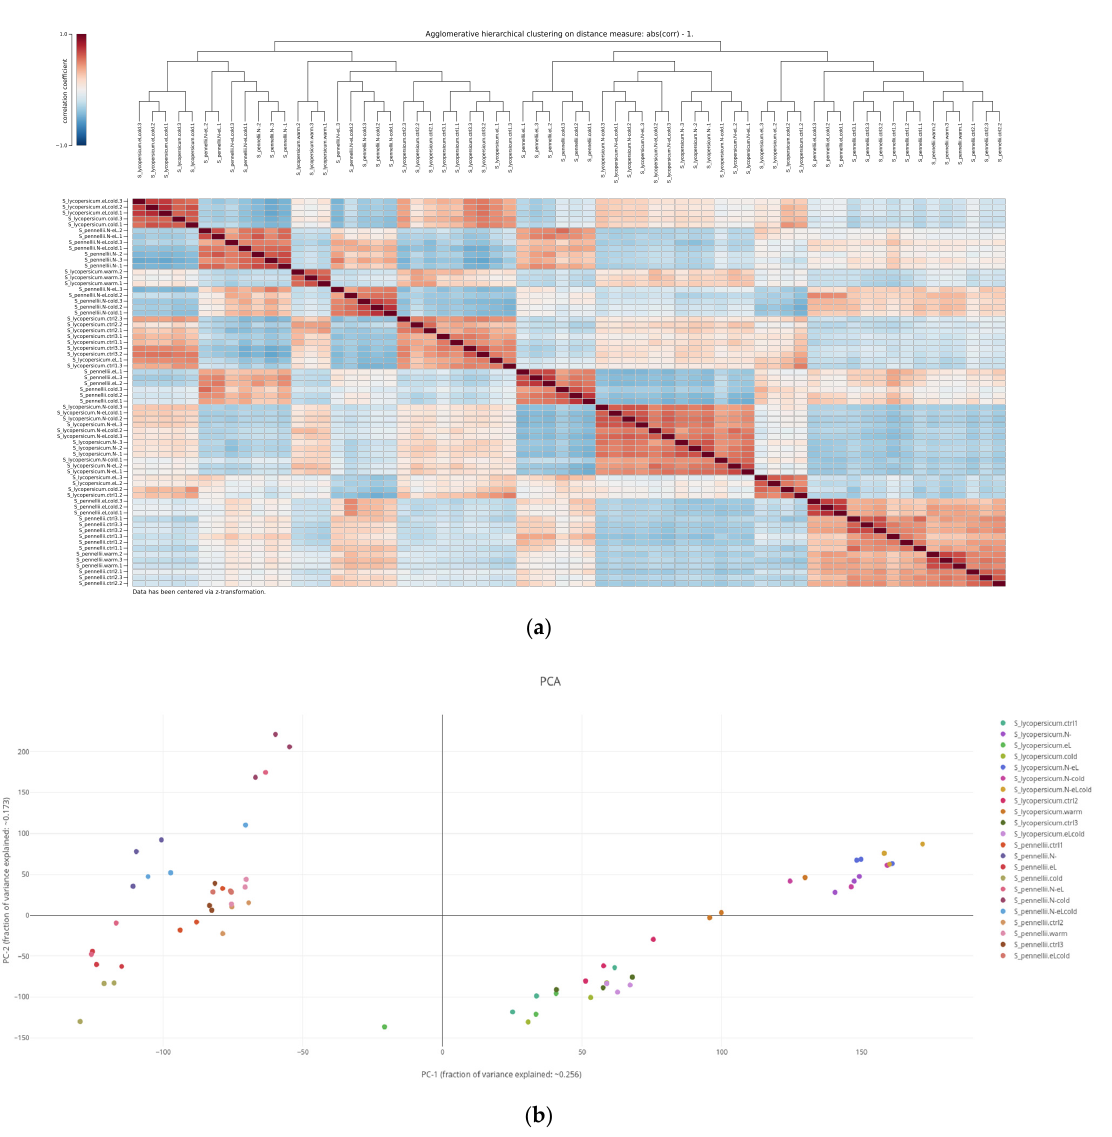
Figure 3. Screenshots of plots investigating likeliness of gene expression assessed in different bio- logical replicates. Plot ( a ) shows the result of correlation-based hierarchical clustering in the form of a dendrogram and a correlation heatmap. In the top left corner, a scale color-codes the calculated correlation coefficients. In the top middle, the dendrogram represents the result of hierarchical clustering of all loaded biological replicates. In this example, the plot informs the user of their choice to z-transform the data before the calculation of correlation (lower left corner). Upon hovering with the mouse over single cells of the correlation matrix, the user is presented with the respective correlation value between the two biological replicates represented by the cell’s row and column, respectively. This example shows how Gene Expression Plotter (GXP) helps the user to assess how well the applied experimental conditions and treatments are reflected in terms of quantified gene expression. Here, serving as a quality check, the statistical factors “species” and “stress treatments” mostly imply the grouping of biological replicates, highlighting that the experimental setup and namely to elucidate the genetic responses to the applied stress treatments and subsequently